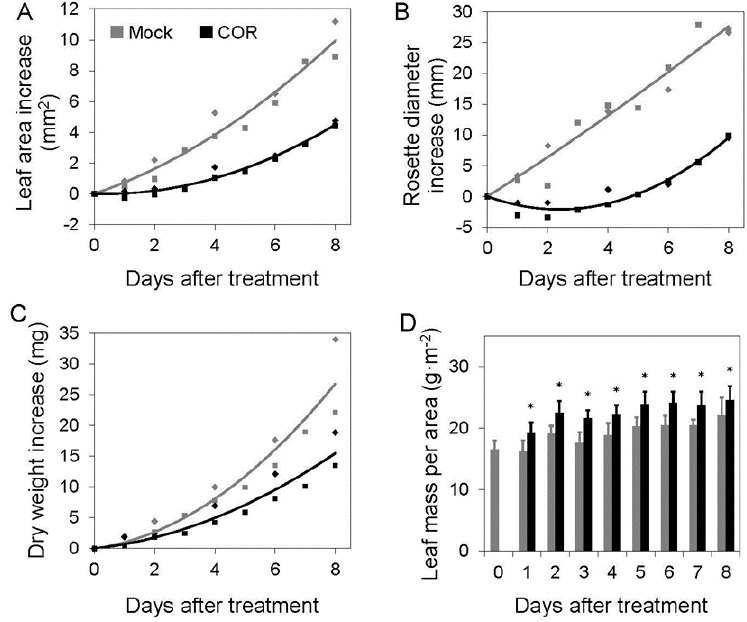
Figure 3. Jasmonate-mediated suppression of leaf area and biomass growth in Arabidopsis thaliana plants. Soil-grown Columbia-0 plants treated with mock (grey) or with 5 µM coronatine (COR, black) solutions [71] were measured for leaf area ( A ), rosette diameter ( B ), and dry weight ( C ) at indicated times after treatment. Data are the mean increase in growth ( n = 12 plants) relative to the day of treatment (day 0) from two independent experiments (diamonds and squares distinguish experiments) and lines are second-order polynomial regressions of combined data from both experiments. Projected leaf area and rosette diameter were determined from overhead images, and dry weight was determined from rosettes (without roots) freeze-dried in a lyophilizer. In ( D ), leaf mass per area (LMA) was calculated from dry weight / leaf area from one experiment in A and C (square points). Error bars are standard deviation and asterisks indicate P < 0.05 between mock and COR treatment from a Student’s t-Test.